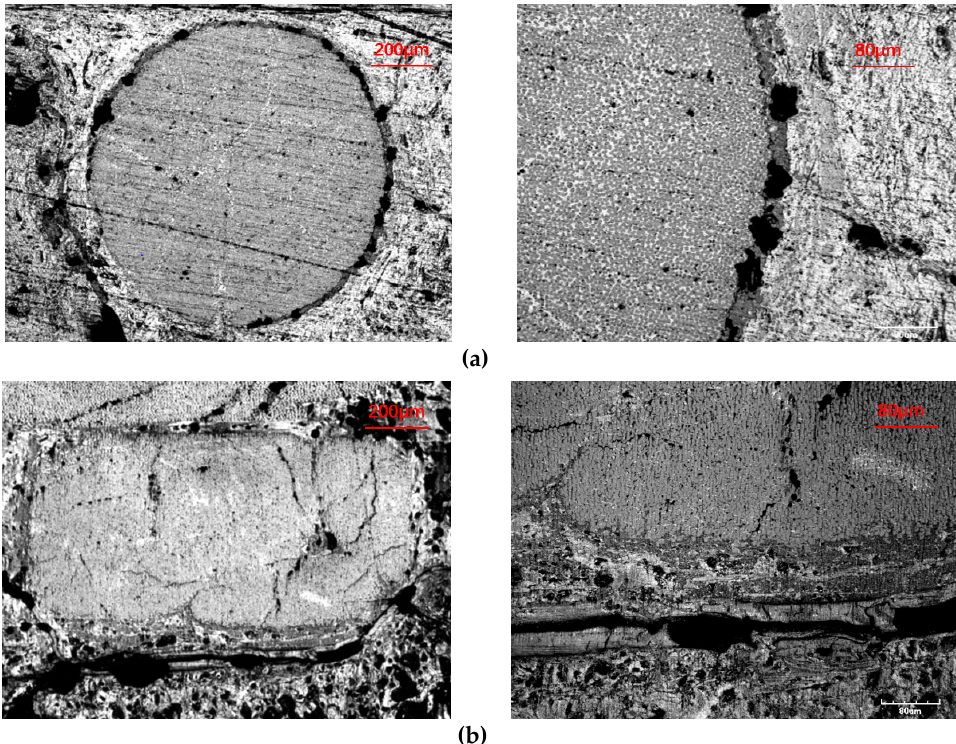
Figure 10. Surface microstructure characteristics of the interface of axially braided C/C composites. (a) Microstructure of interface layer of fiber rod by SEM; (b) Microstructure of interface layer of fiber ( a ) Microstructure of interface layer of fiber rod by SEM; ( b ) Microstructure of interface layer of